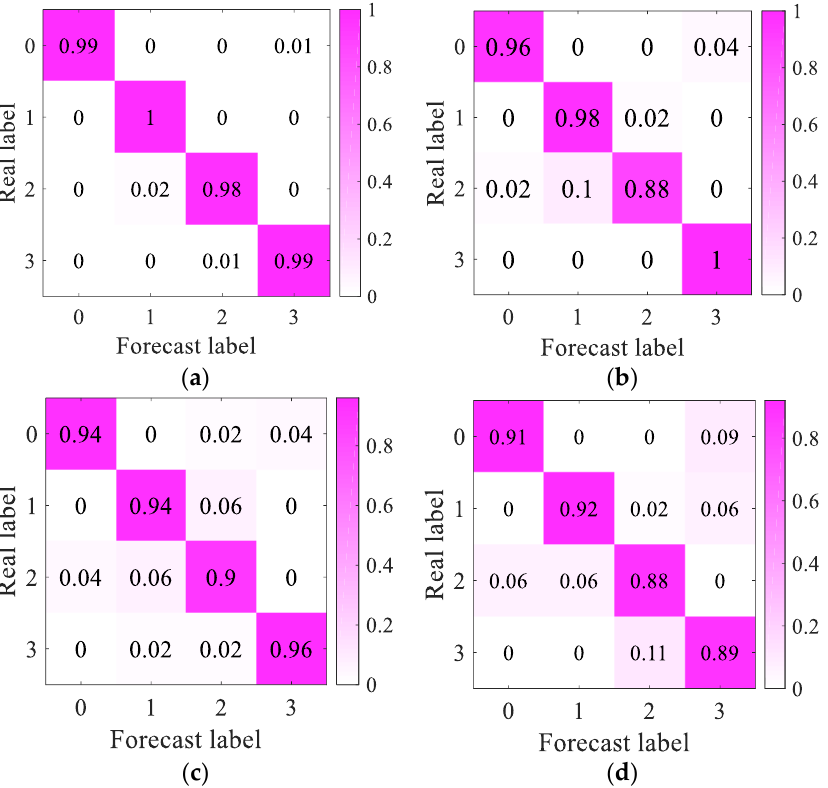
Figure 8. Fault classification confusion matrix. ( a ) Mel - Mixup; ( b ) Mel - Basic data enhancement; ( c ) Time - frequency - Mixup; ( d ) Time - frequency - Basic data enhancement.